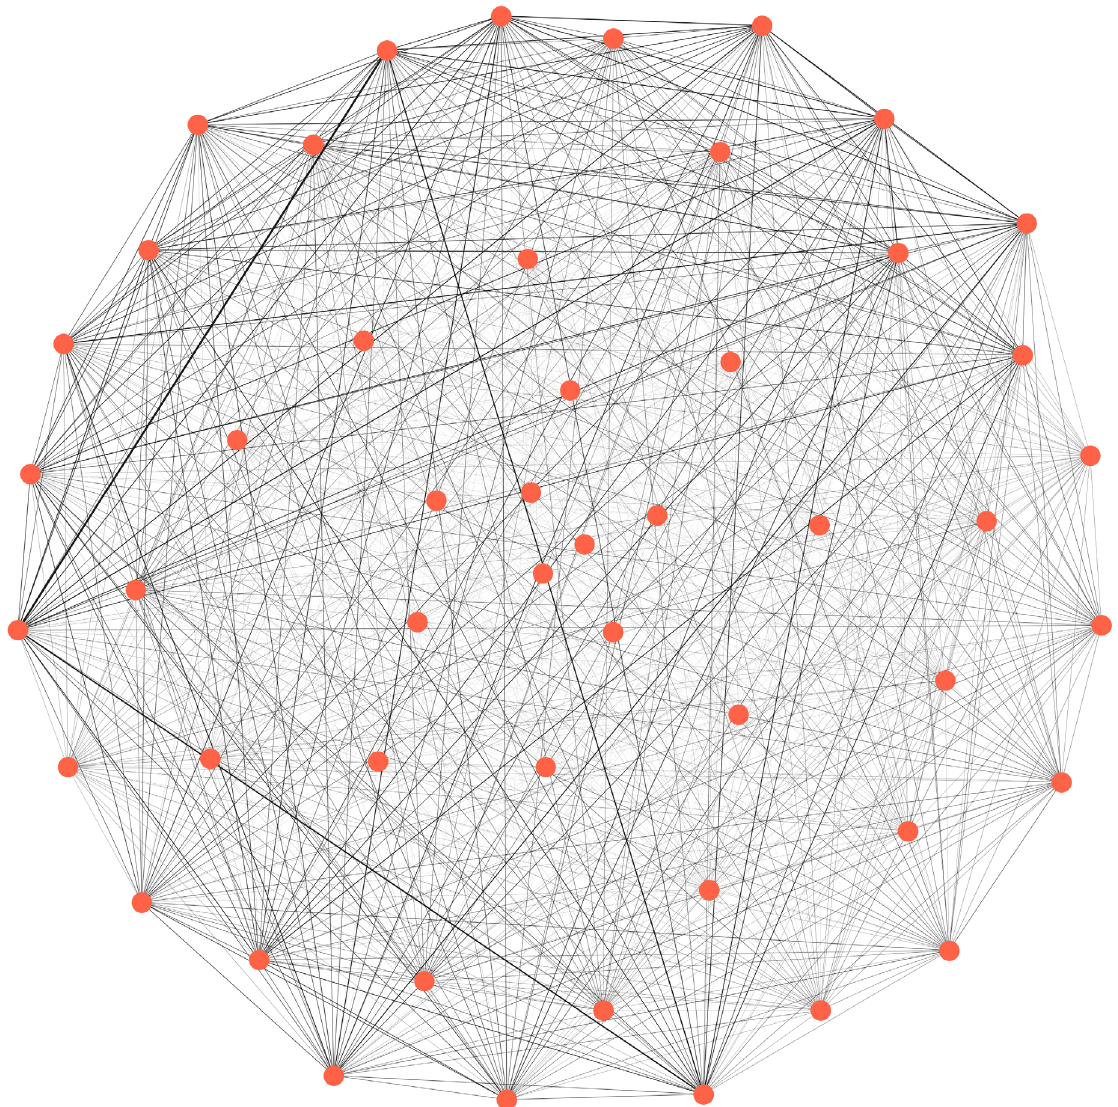
Fig. 7. A partial representation (i.e., 50 nodes) of the fully connected graph obtained from our complete dataset (i.e., 12,172 nodes). Each node (red dot) represents an sTEC pro fi le, and the edges of different widths represent the similarity between nodes, de fi ned by the EMD